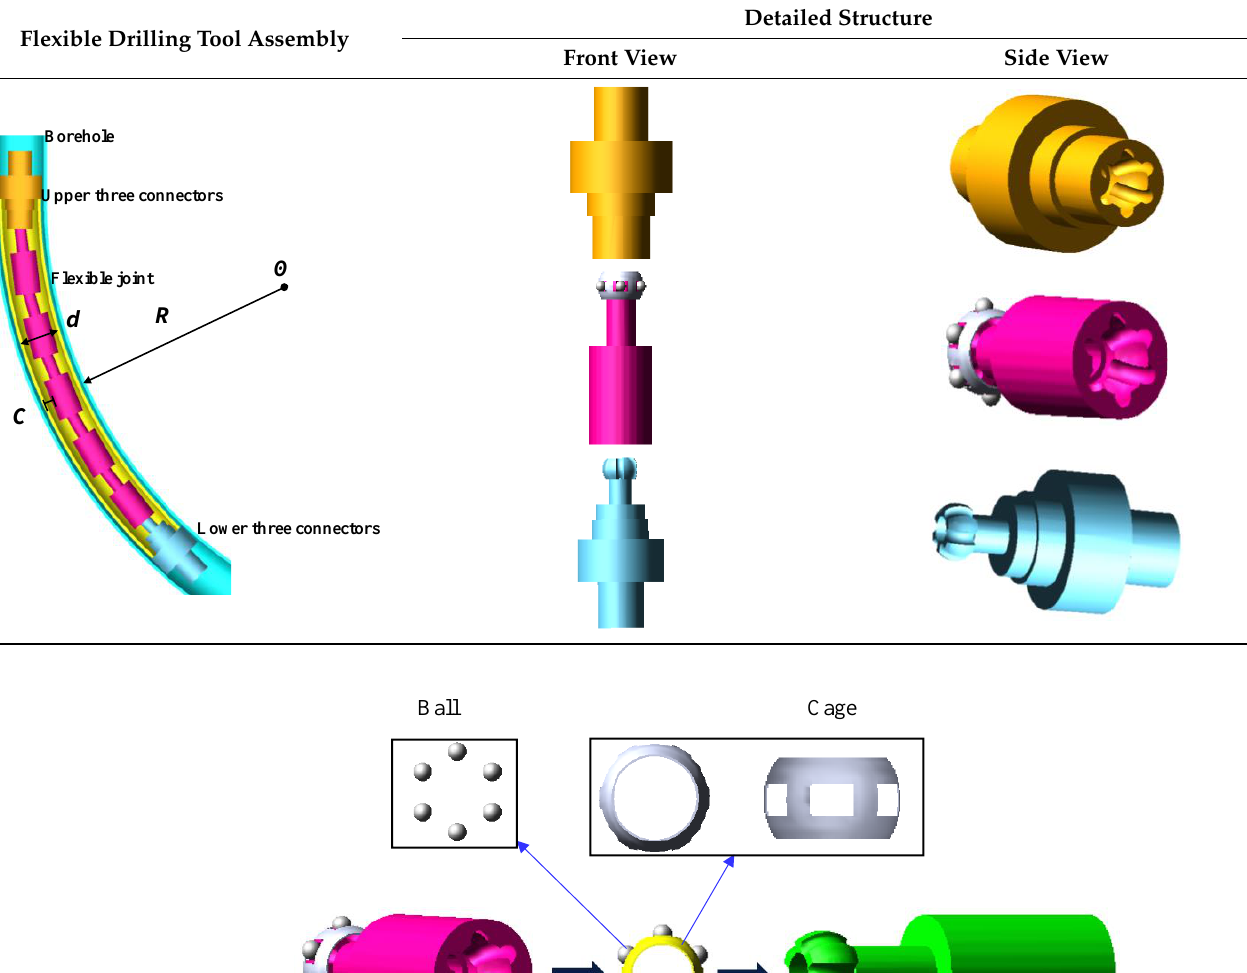
4 of 18 Table 1. Structure components of ball cage flexible drilling pipe.